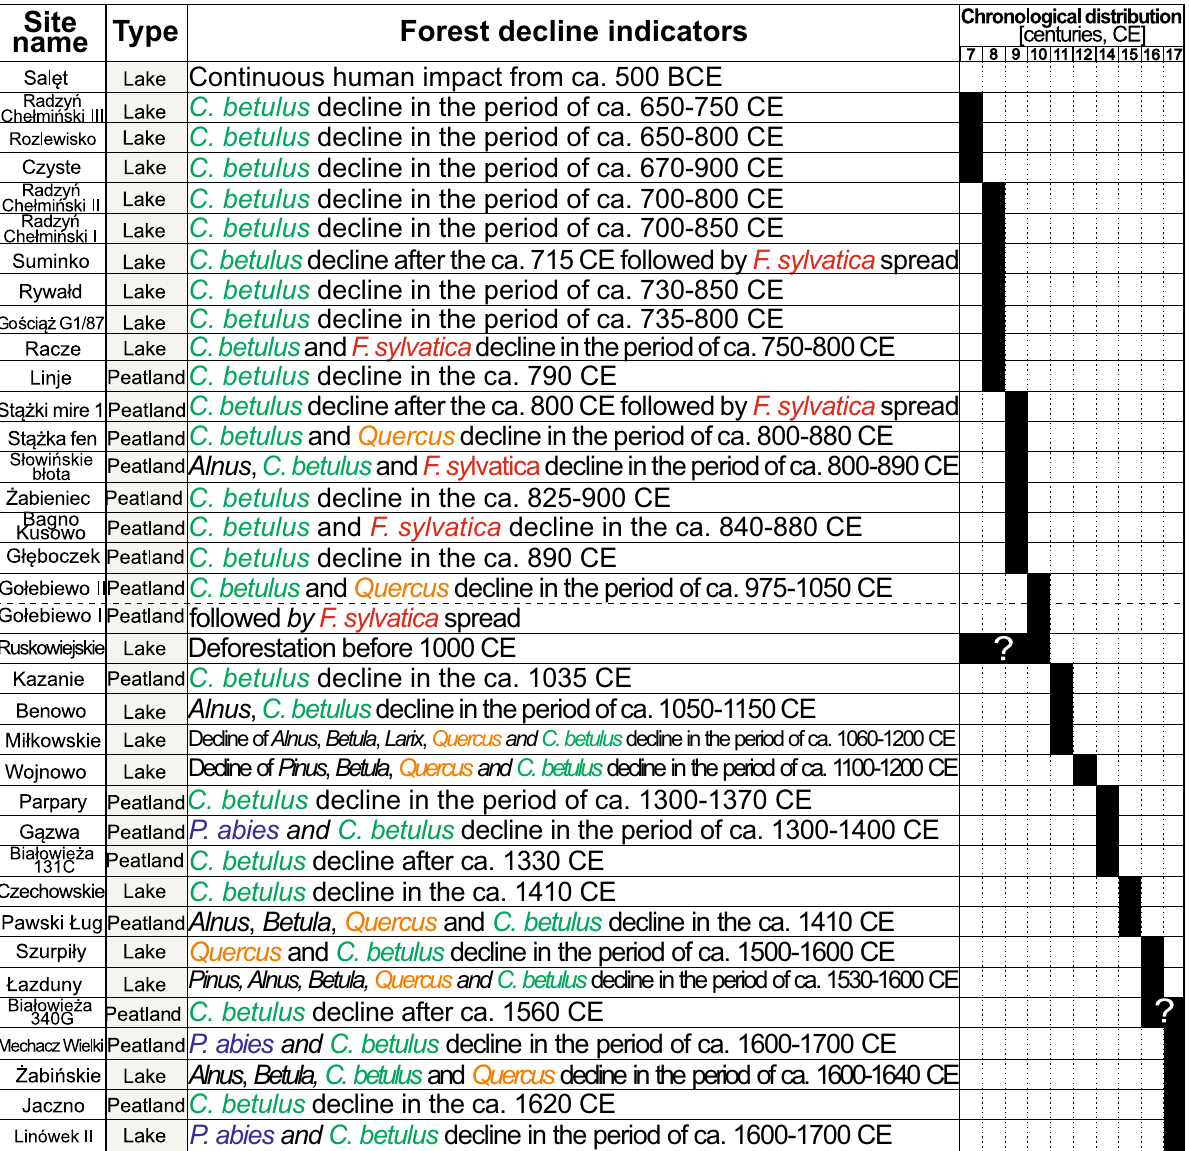
Figure 3. Beginning of forest decline after the Migration Period as recorded at selected sites in the Polish Lowlands during the last 1500 years. Centuries are indicated as i.e. 801–900 CE. For details regarding the sites see Table